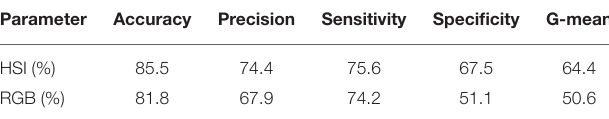
TABLE 2 | Comparison of performance of HSI and RGB imaging for the distinction of erythema